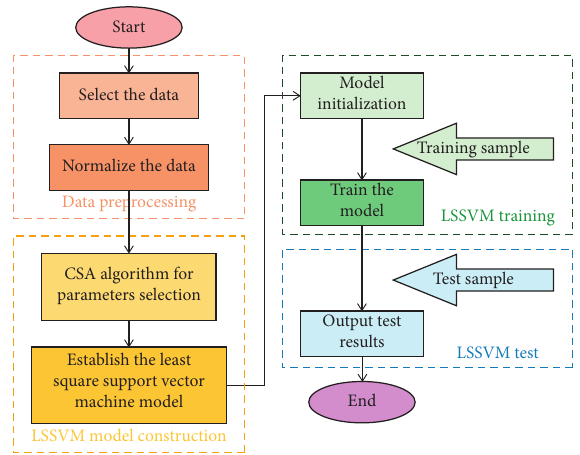
Figure 6: The flowchart of CSA-LSSVM method.